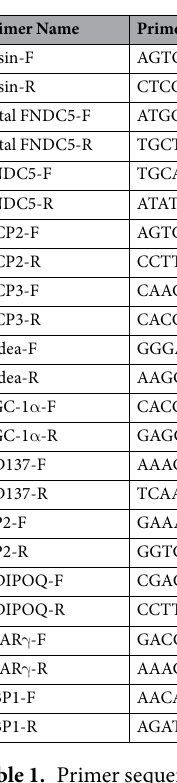
Table 1. Primer sequences used for RT-PCR and